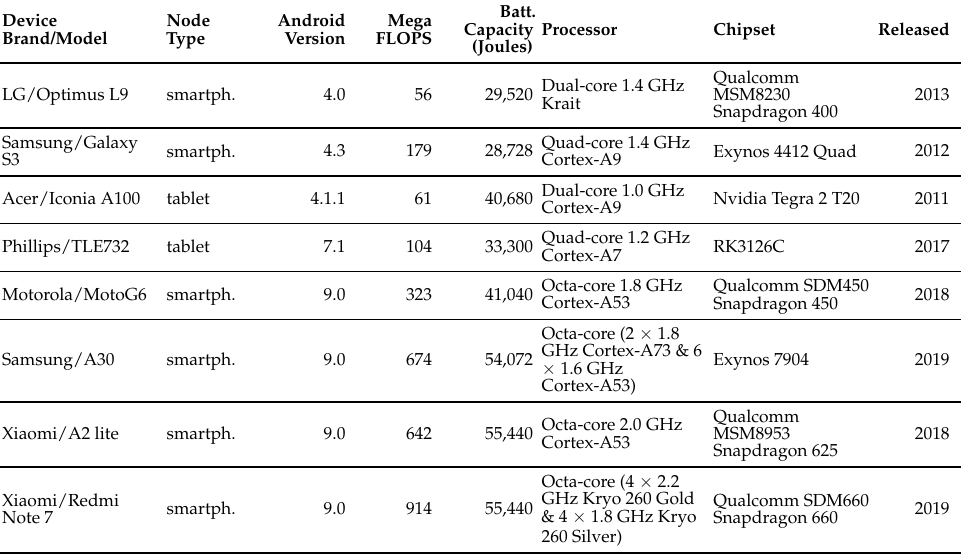
Table 1. Computing-related node-level features.